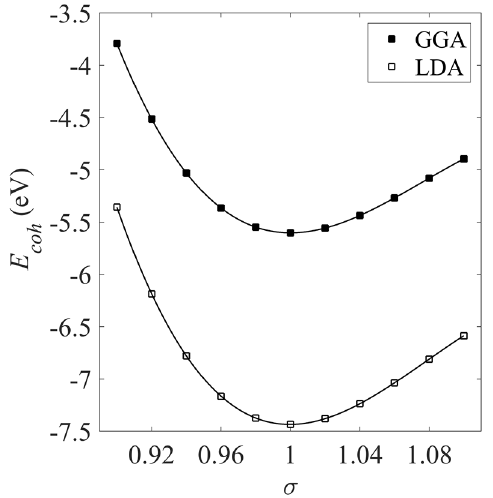
Figure 2. Cohesive energy E coh of the bulk Pt crystal estimated using both the LDA and GGA estimates of the